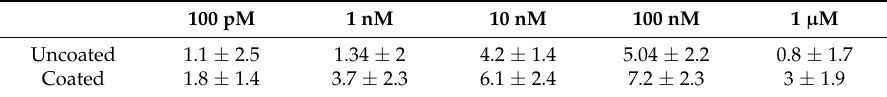
Figure 8. Cell viability of 4T1 cells after 48 h of treatment with anastrozole-loaded CA and surface modified, gemcitabine-loaded CA. Surface-modified CA denotes the particles modified with streptavidin–biotin–PEG and fibronectin. Values were significant (*) at p value 0.01 to 0.05, very significant (**) at p value 0.001 to 0.01, extremely significant (***) at p value 0.0001 to 0.001, and extremely significant (****) at p value < 0.0001. Table 5. Enhancement of cytotoxicity (%) for anastrozole-loaded CA in MCF7. 100 pM